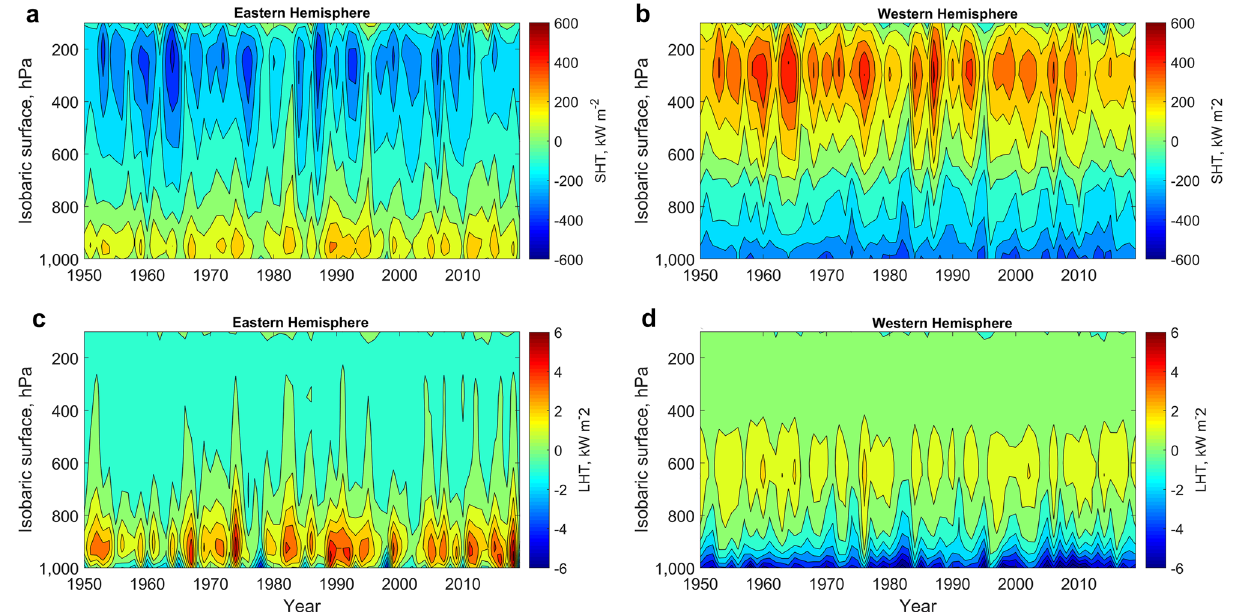
Figure 3. Vertical cross-section of heat transport components (kW m −2 ), their interannual variability and the anti-phase pattern between the hemispheres. ( a ) Annual average sensible heat transport in the Eastern Hemisphere (0°–179.75°E). ( b ) Annual average sensible heat transport in the Western Hemisphere (180°– 0.25°W). ( c ) Annual average latent heat transport in the Eastern Hemisphere (0°–179.75°E). ( d ) Annual average latent heat transport in the Western Hemisphere (180°–0.25°W). The positive values indicate northward heat transport. The Matrix Laboratory (MATLAB) with version R2017b (https:// www. mathw orks. com/) was used to generate this